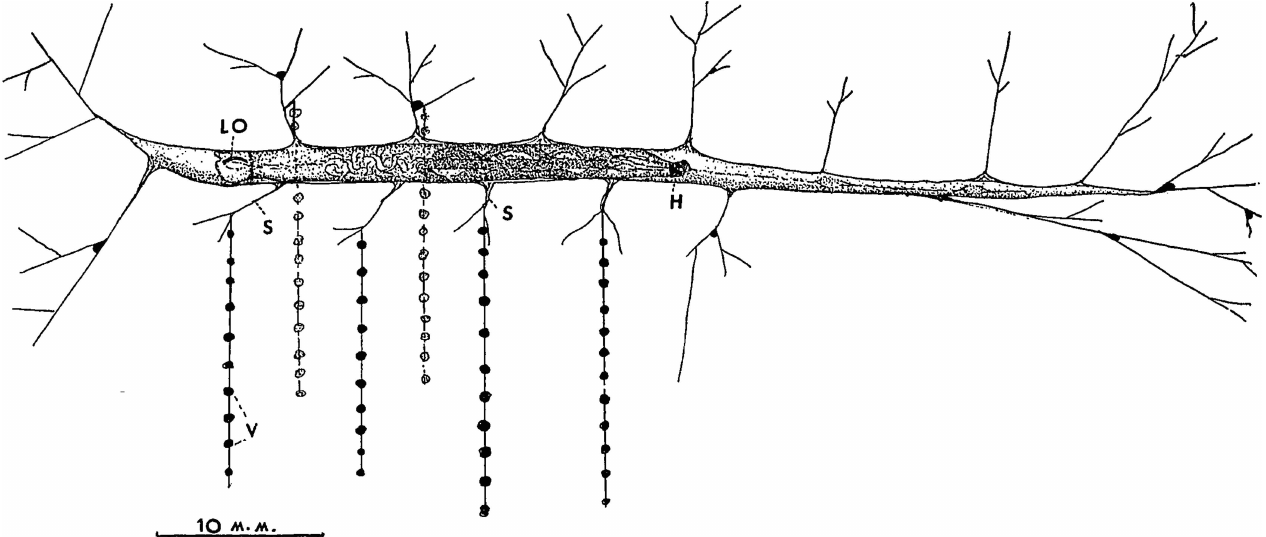
Fig 1. Arachnocampa larva within its tube, moving from left to right with its head (h). The larva attracts the prey with its light organ (LO) and then catches it with adhesivethreads, made of silk (s) and adhesivevesicles (v). Image by Gatenby (1959) and reproducedwith the permissionof the Royal Society of New